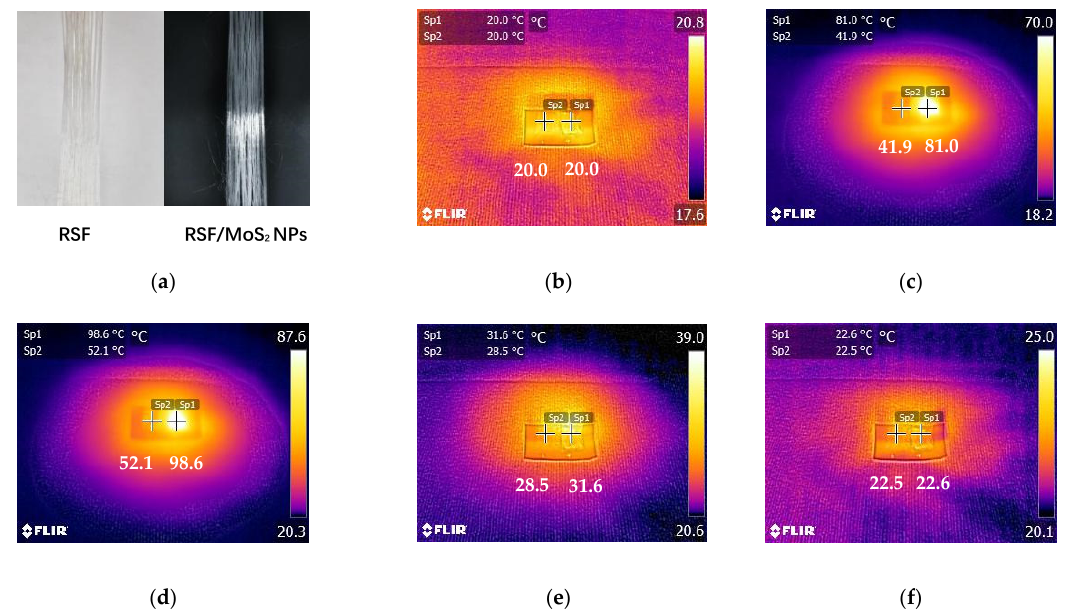
Figure 8. Temperature change of RSF fibers and 2 wt% RSF/MoS 2 NPs hybrid fibers under the irradiation of simulated sunlight.( a ) RSF fibers and RSF/MoS 2 NPs hybrid fibers; ( b ) at the beginning of irradiation; ( c ) after irradiation for 1 min; ( d ) after irradiation for 10 min; ( e ) stop the irradiation for 1 min; ( f ) stop the irradiation for 10 min.